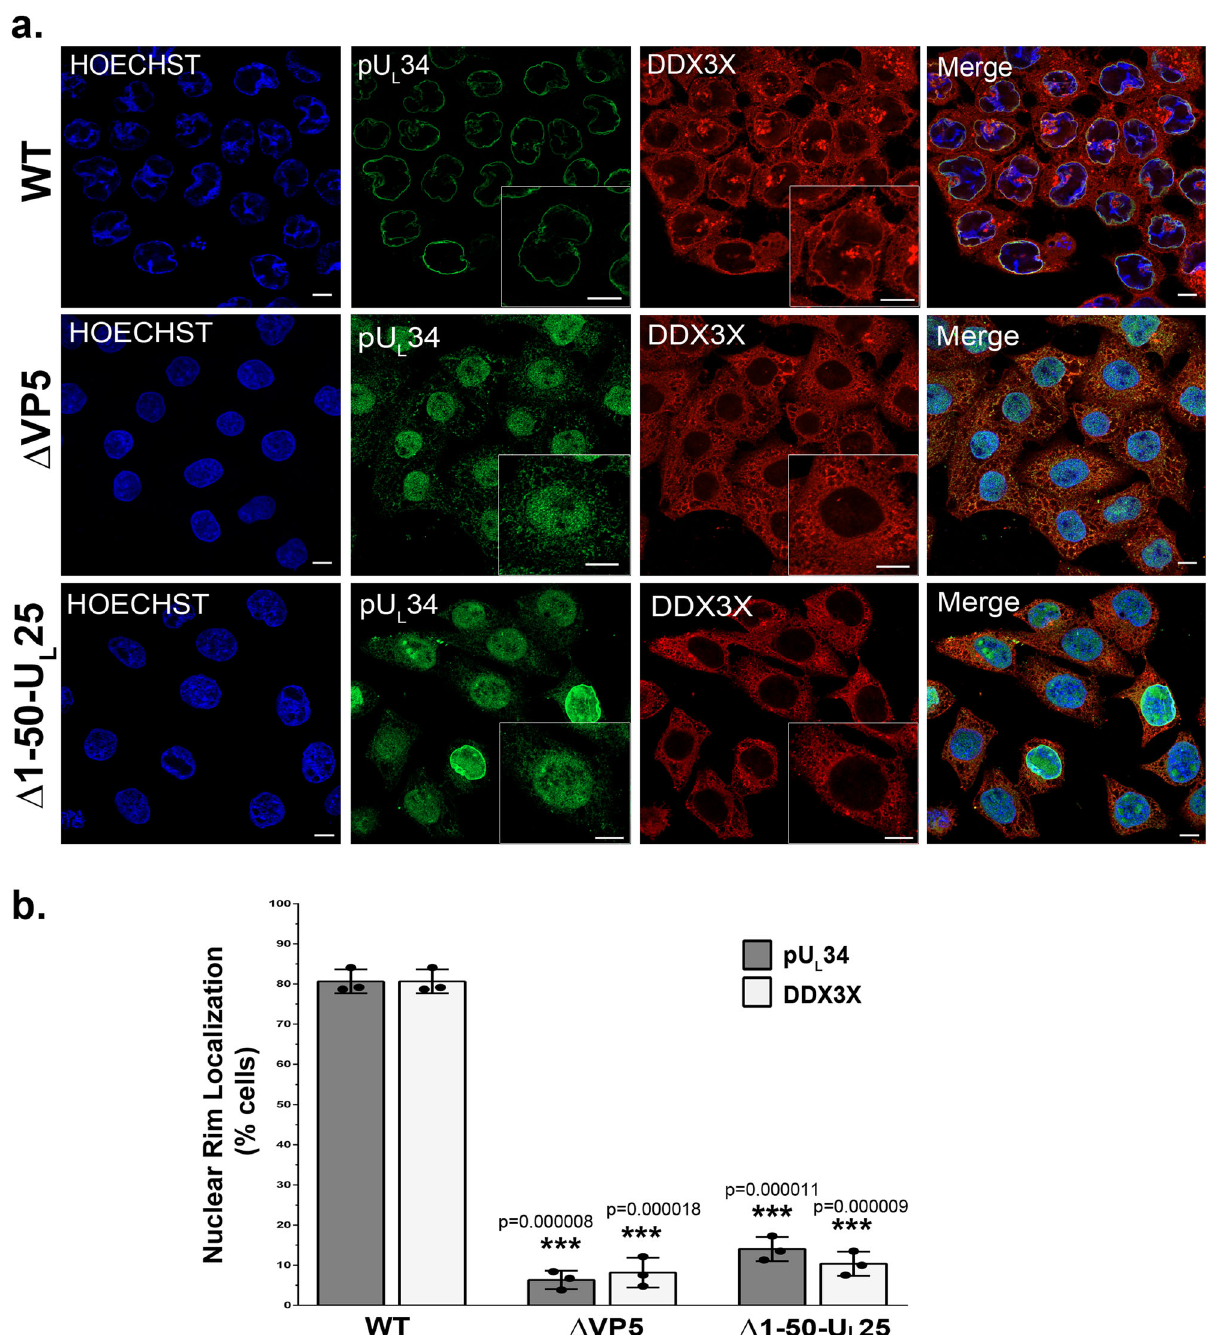
Fig. 7 The presence of DDX3X on nuclear membranes is C-capsid dependent. a HeLa cells seeded on coverslips were either mock-treated or infected at an MOI of 5 with the Δ VP5 or Δ 1-50 U L 25 mutant viruses or the corresponding KOS wild-type virus. The cells were fi xed at 9 hpi and labelled for DDX3X (red), pU L 34 (green) and Hoechst 33342 stained nuclei (blue). Zoom boxes were added to highlight DDX3X and pU L 34 localisation in each condition. All scale bars represent 5 µ m. b Quanti fi cation of the nuclear pU L 34 and DDX3X using 100 random cells per condition. Bars indicate means and the standard deviation of the means (bilateral Student T -tests; *** p < 0.001). The data represents three independent